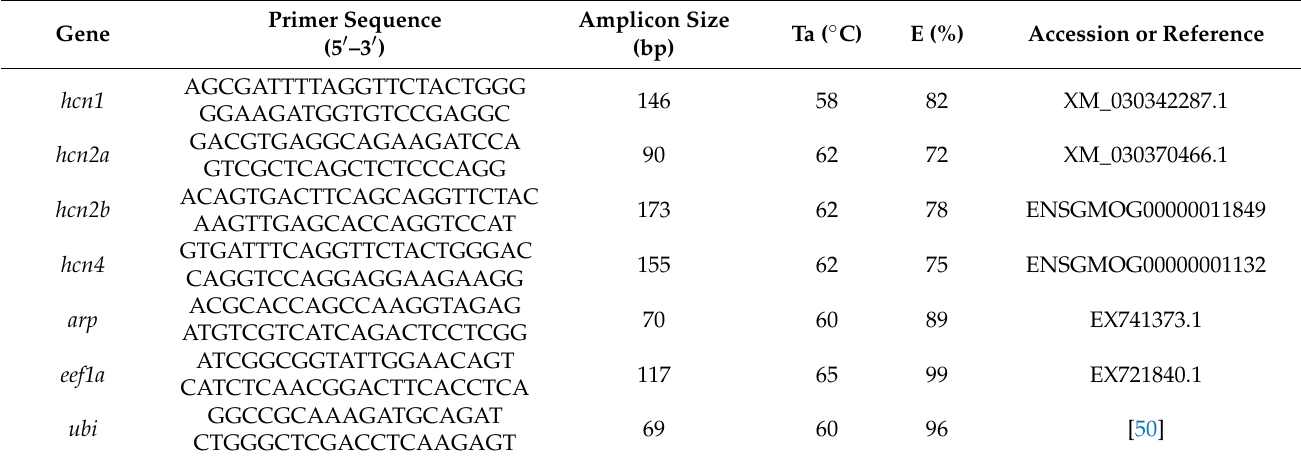
initial denaturation at 95 ◦ C for 10 min, followed by 45 cycles at 95 ◦ C for 10 s, optimized annealing temperature (58–65 ◦ C) for each gene (Table 2) for 30 s and 72 ◦ C for 20 s. The specificity of amplification was determined by melting curve analysis. The standard curve was obtained by running a 5-point series of 2-fold dilution (1:2, 1:4, 1:8, 1:16 and 1:32) pooled cDNA. Relative expression of the target genes was determined using GeNorm [48], as reported in [49]. The geometric means of the two most stable reference genes ( eef1a and ubi ) were used as calibrators. Differences in hcn transcript levels in each heart area were determined by one-way ANOVA with a Holm–Sidak post hoc test ( p < 0.05). Kruskal– Wallis one-way ANOVA on ranks with Dunn’s post hoc test was performed when the data did not meet the normality and equal variance requirements. Statistical analyses were performed with the SigmaStat statistical package (Systat software, UK). Table 2. Details of the primers used for relative quantification of mRNA levels by qPCR. In addition to the primer sequences used to quantify each transcript level, amplicon sizes, annealing temperatures (Ta) and amplification efficiencies (E) are